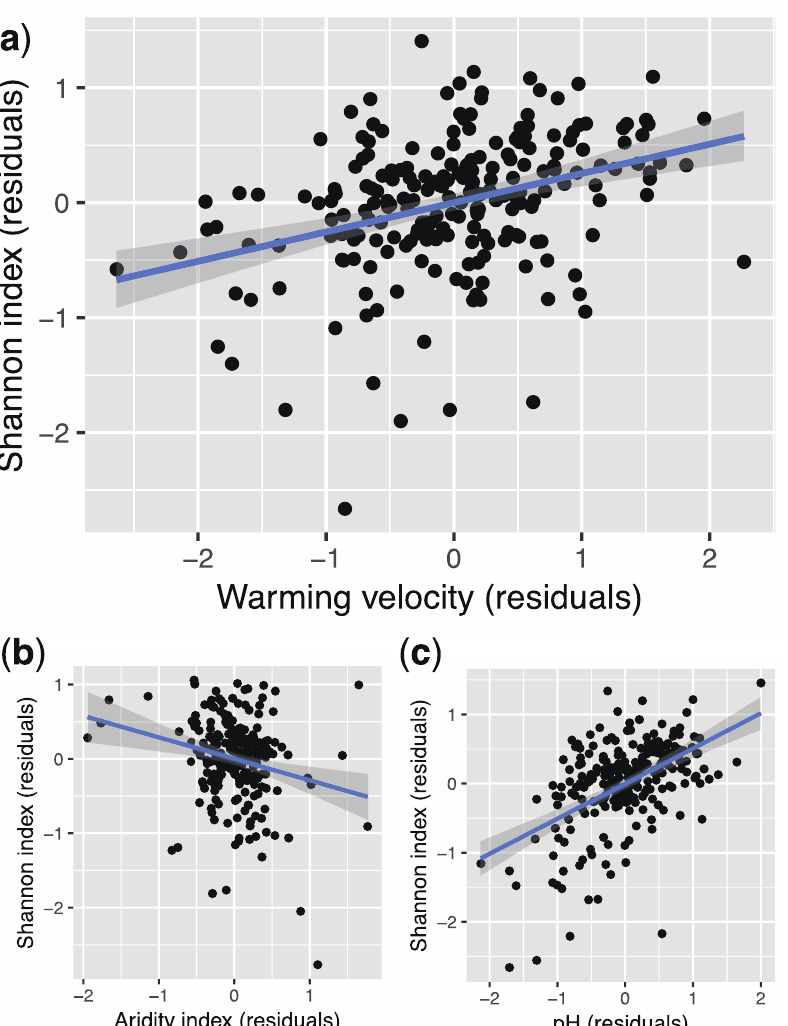
Figure 1. Scatter plots of the diversity (Shannon index) of soil dominant bacteria (residuals) versus environmental parameters (residuals). ( a ) Shannon index versus warming velocity. ( b ) Shannon index versus aridity index. ( c ) Shannon index versus pH. The shaded gray area indicates the 95% confidence intervals around the regression lines.